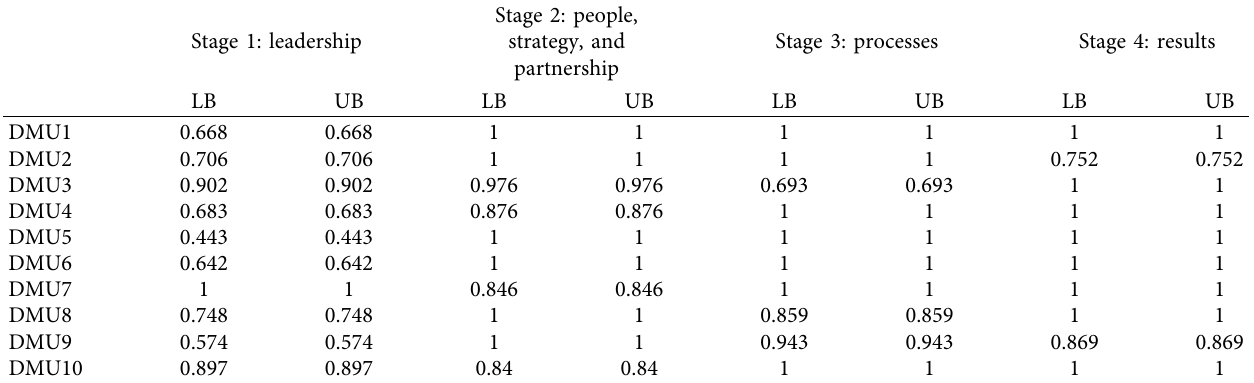
Table 8: The efficiency of EFQM stages at α �